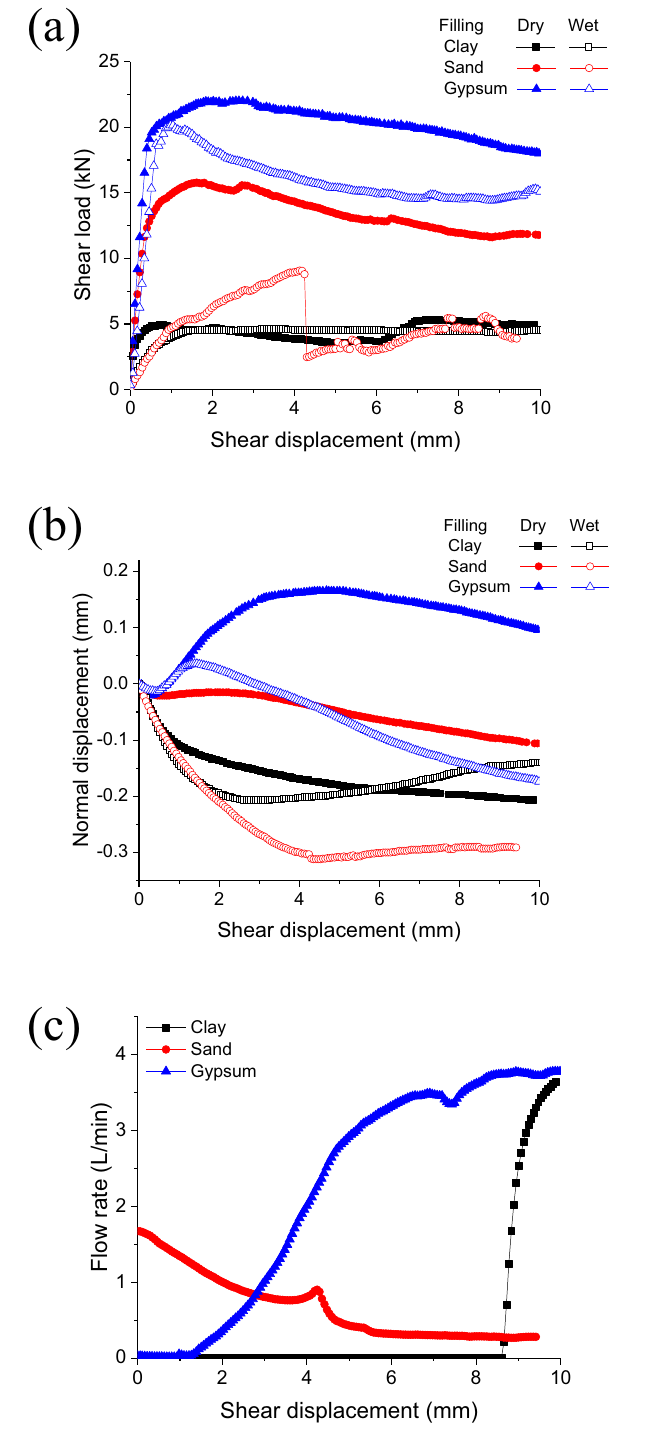
Figure 11. Contrasting curves for different gouge fill materials: ( a ) shear load versus shear displacement, ( b ) normal displacement versus shear displacement, ( c ) flow rate versus shear